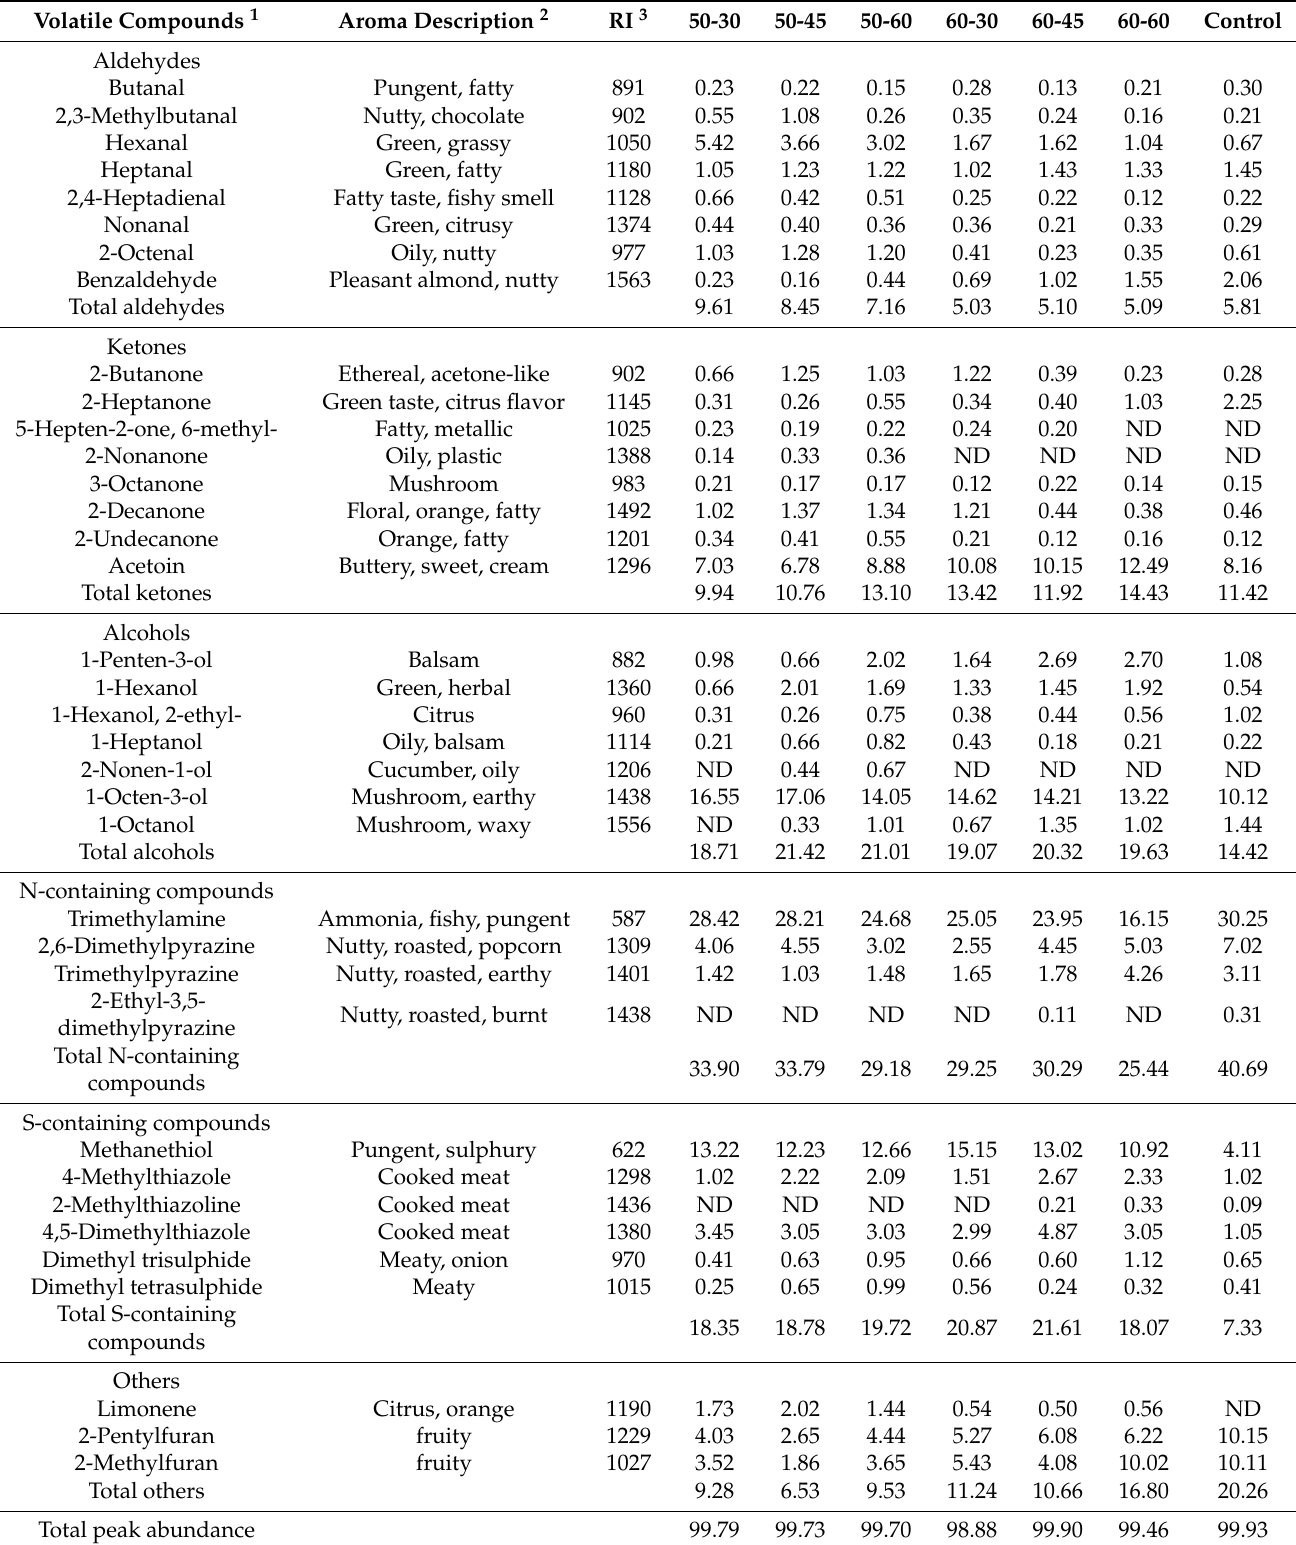
Table 2. Volatile profile SV-cooked tilapia processed by various SV